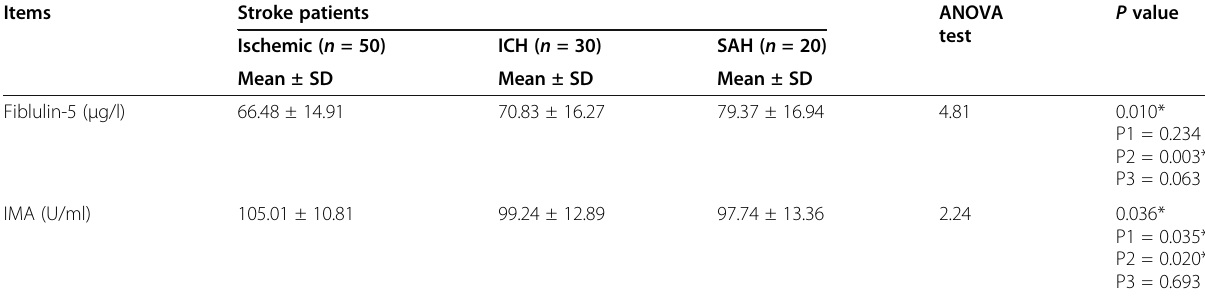
Table 3 Comparison between fibulin-5 and IMA levels in ischemic and hemorrhagic cerebrovascular stroke